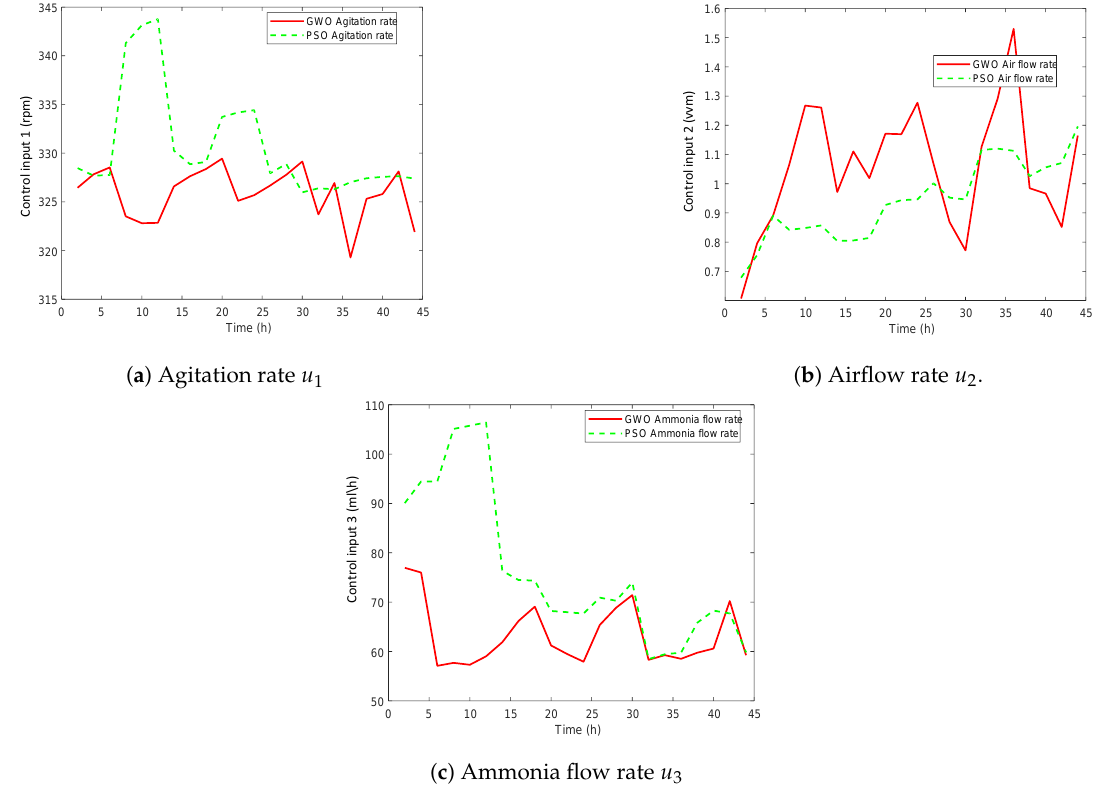
Figure 6. GWO-NMPC controlled inputs with hypothetical